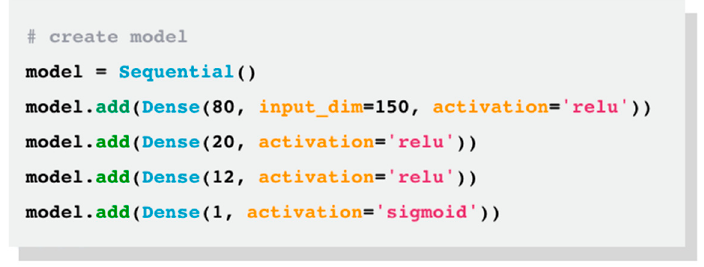
Figure 15. Create ANN model.